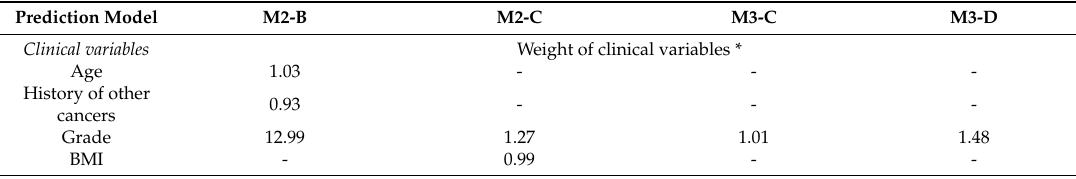
Table 5. Variables included in the best performing prediction models. Performance of these models was measured by AUC, sensitivity, specificity, and positive and negative prediction values in both the UI (testing) and TCGA (validation) datasets. * Weights for clinical variables were calculated as the exponential of the estimate in the Lasso regression model. Then, the score of the variable is calculated multiplying the weight of the variable by its value. For example, for age, the score is the weight of age, 1.03 times the age in years; for grade, the score is the weight, 12.99, 1.48, or 1.71 times the numerical grade of the tumor (weights differs among the various models). ** Details of individual weights for miRNA expression are in Table A1. # Details of individual weights for somatic mutations are in Table A2. ## Details of individual weights for gene expression are in Table